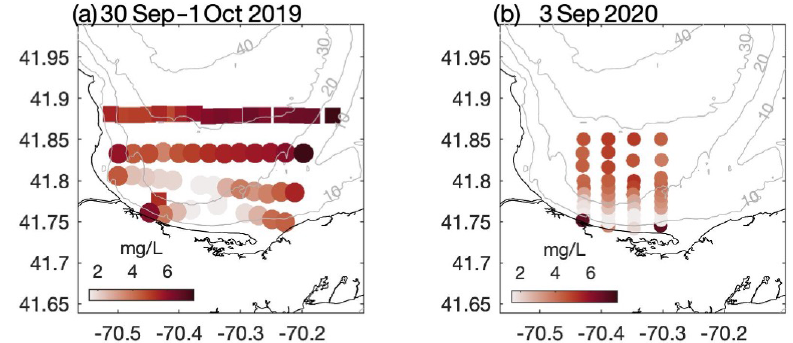
Figure 2. Bottom dissolved oxygen measured in southern CCB during late summer (a) 2019 and (b) 2020. In 2019 data were collected on 30 September (squares) and 1 October (circles). In both years a broad region of hypoxic bottom water developed in relatively shallow water where the thermocline intersects the seafloor. Grey contours are depths in